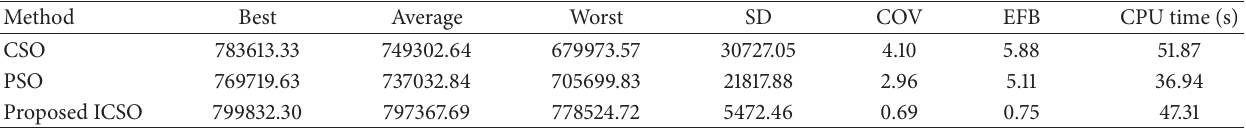
Table 6: Comparison of solution